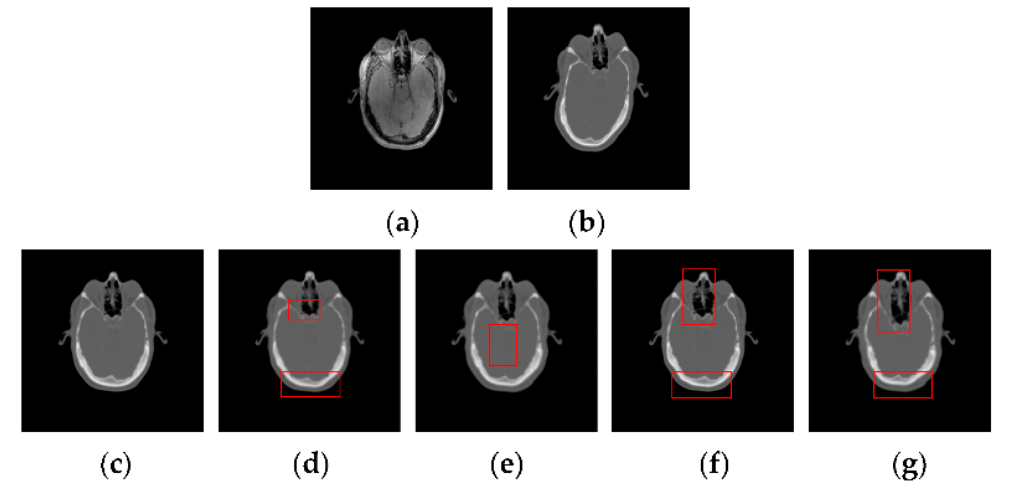
Figure 15. CT-MR image registration results for the PSR, MIND, ESSD, WLD, and NMI methods. ( a ) The reference PD image; ( b ) The floating CT image; ( c ) PSR method; ( d ) MIND method; ( e ) ESSD method; ( f ) WLD method; ( g ) NMI method.